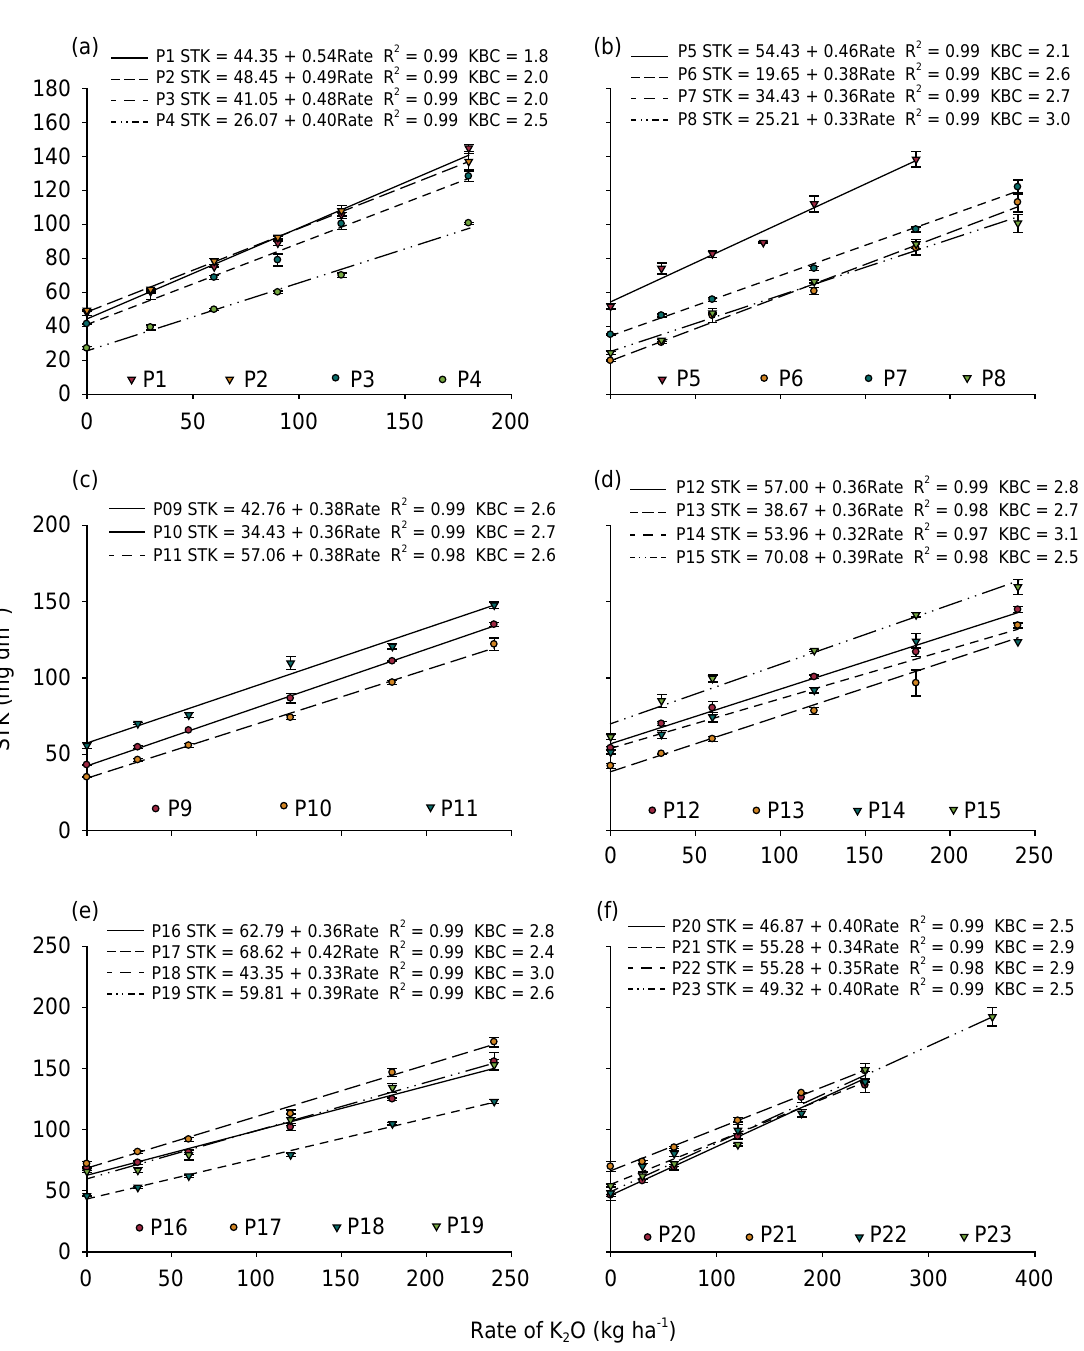
Figure 2. Soil Test Potassium (STK) by Mehlich-1 in 23 soil samples after incubation with rates of K 2 O in southern Brazil soils. The soils were arranged in ascending CEC pH7.0 order (a: 2.9; 4.2; 4.8; and 6.7 cmol c dm -3 ; b: 7.0; 7.7; 8.2; and 8.5 cmol c dm -3 ; c: 9.4; 10.1; and 10.4 cmol c dm -3 ; d: 10.8; 11.1; 11.3 and 11.8 cmol c dm -3 ; e: 11.8; 12.2; 12.7; and 13.0 cmol c dm -3 ; f: 13.1; 13.6; 14.1, and 15.5 cmol c dm -3 ) and divided equally among six plots to improve the plotted regressions visualization. No criteria related to results or soils with similar characteristics were